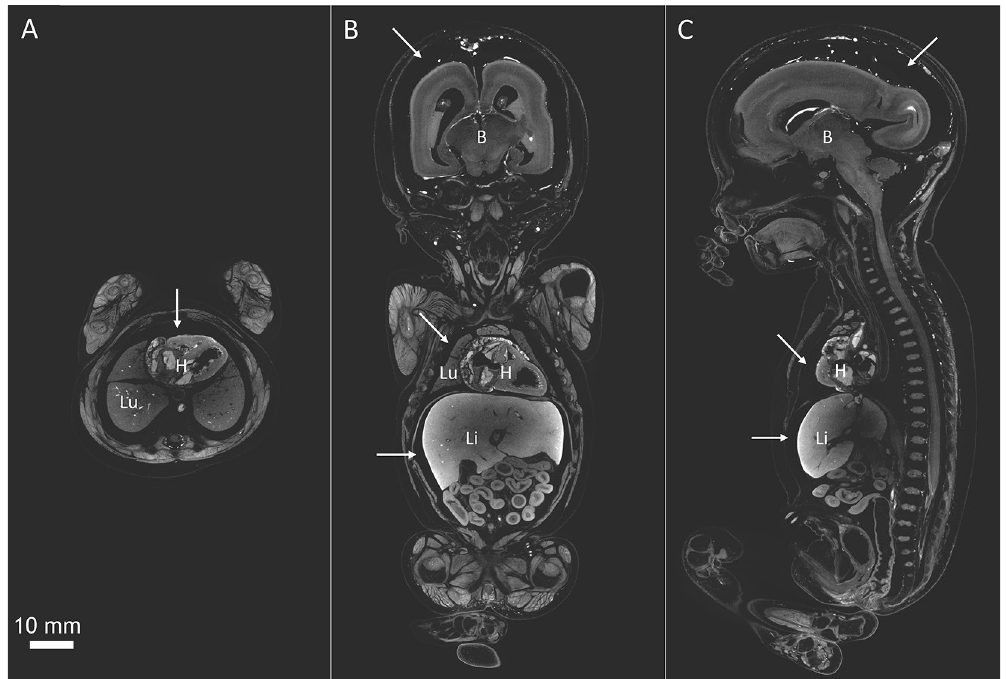
Figure 1. Micro-CT images of a human fetus at 19 weeks of gestation (total length = 24 cm). The fetus was stained with 3.75% Lugol’s solution for 26 days in total. The fetus was scanned on a GE Phoenix v|tome|x scanner (General Electric, Wunstorf, Germany) with an isotropic resolution of 50 µm. ( A ) Transversal section at the level of the heart, ( B ) mid coronal section and ( C ) mid sagittal section. Volume analyses showed that the staining caused extensive shrinkage: 9% in total fetal volume, 24% in lung and liver volume, 31% in kidney volume and 33% in brain volume Images adapted from Organ specific shrinkage in iodine stained human fetuses 13 . White arrows point to the empty space between skull and brain and liver and body cavity, which is reminiscent of soft-tissue shrinkage. B = Brain, H = Heart, Li = Liver, Lu = Lung. Scale bar represents 10